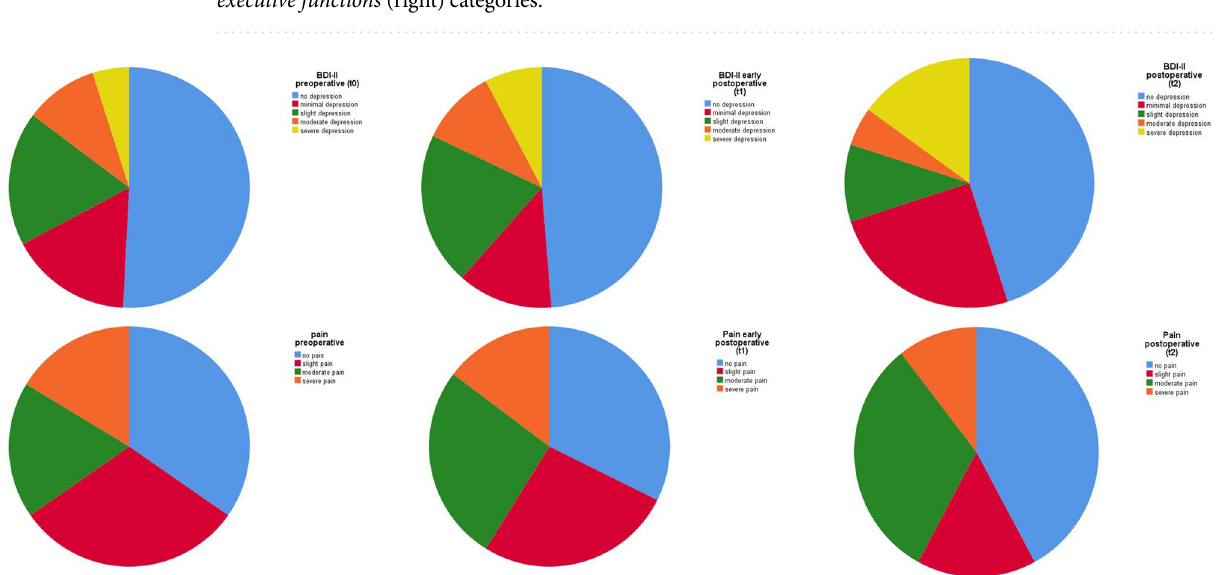
Figure 3. Distributions of mood (BDI-II) and pain before and after